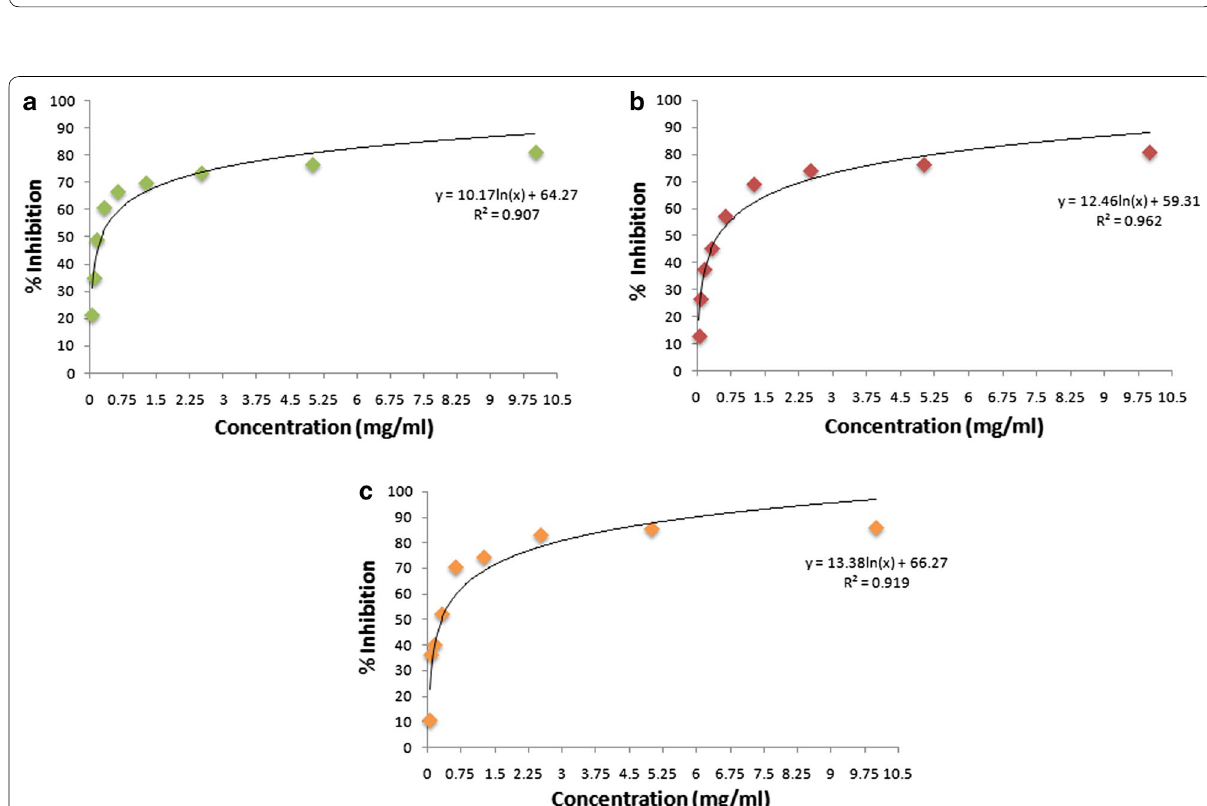
Fig. 4 In vitro cytotoxicity of Berberis aristata root bark on ( a ) RD, ( b ) L20B, ( c ) Hep 2 cell